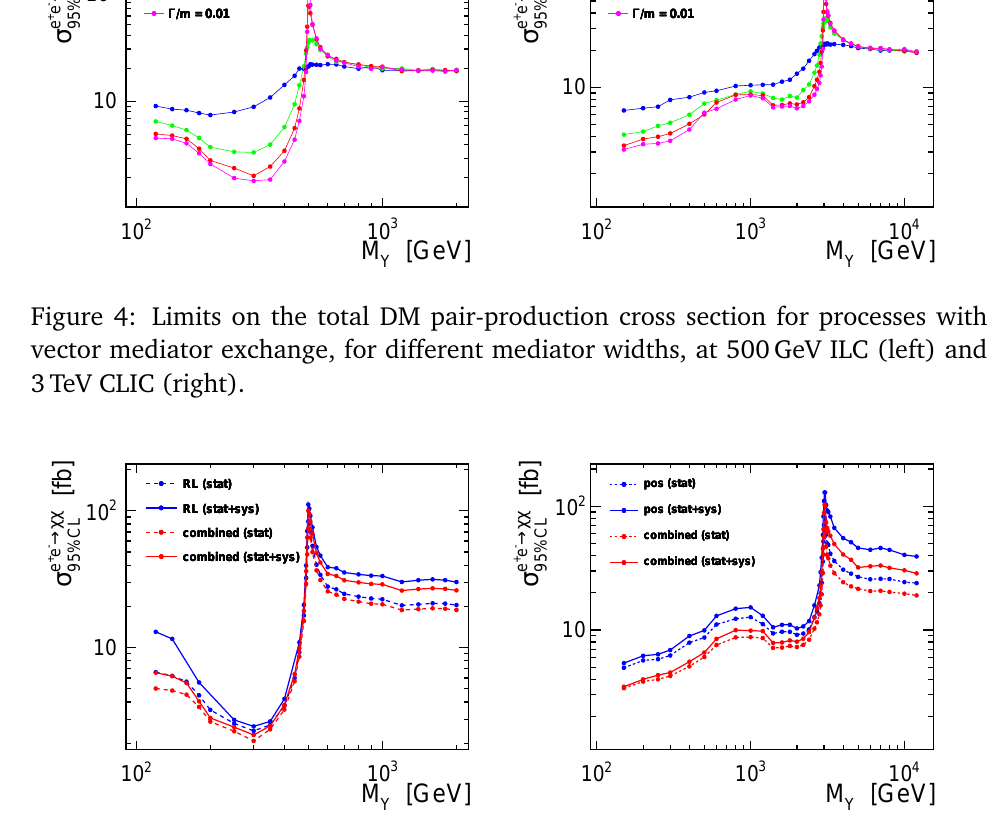
Figure 5: Limits on the total DM pair-production cross section for vector mediator width of Γ / M = 0.03, at 500 GeV ILC (left) and 3 TeV CLIC (right) without (stat) and with (stat + sys) systematic uncertainties taken into